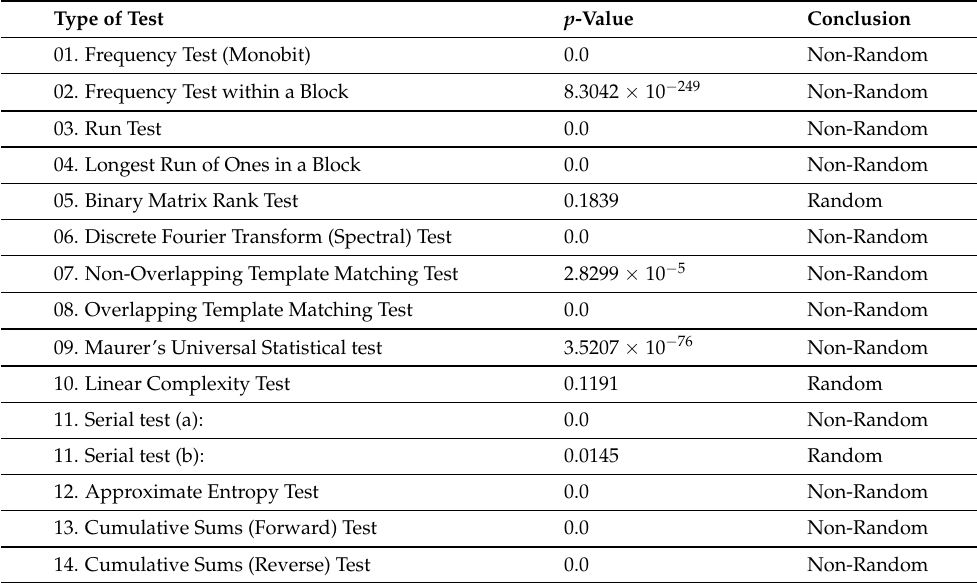
Table 6. NIST randomness tests on a third order Horadam sequence.